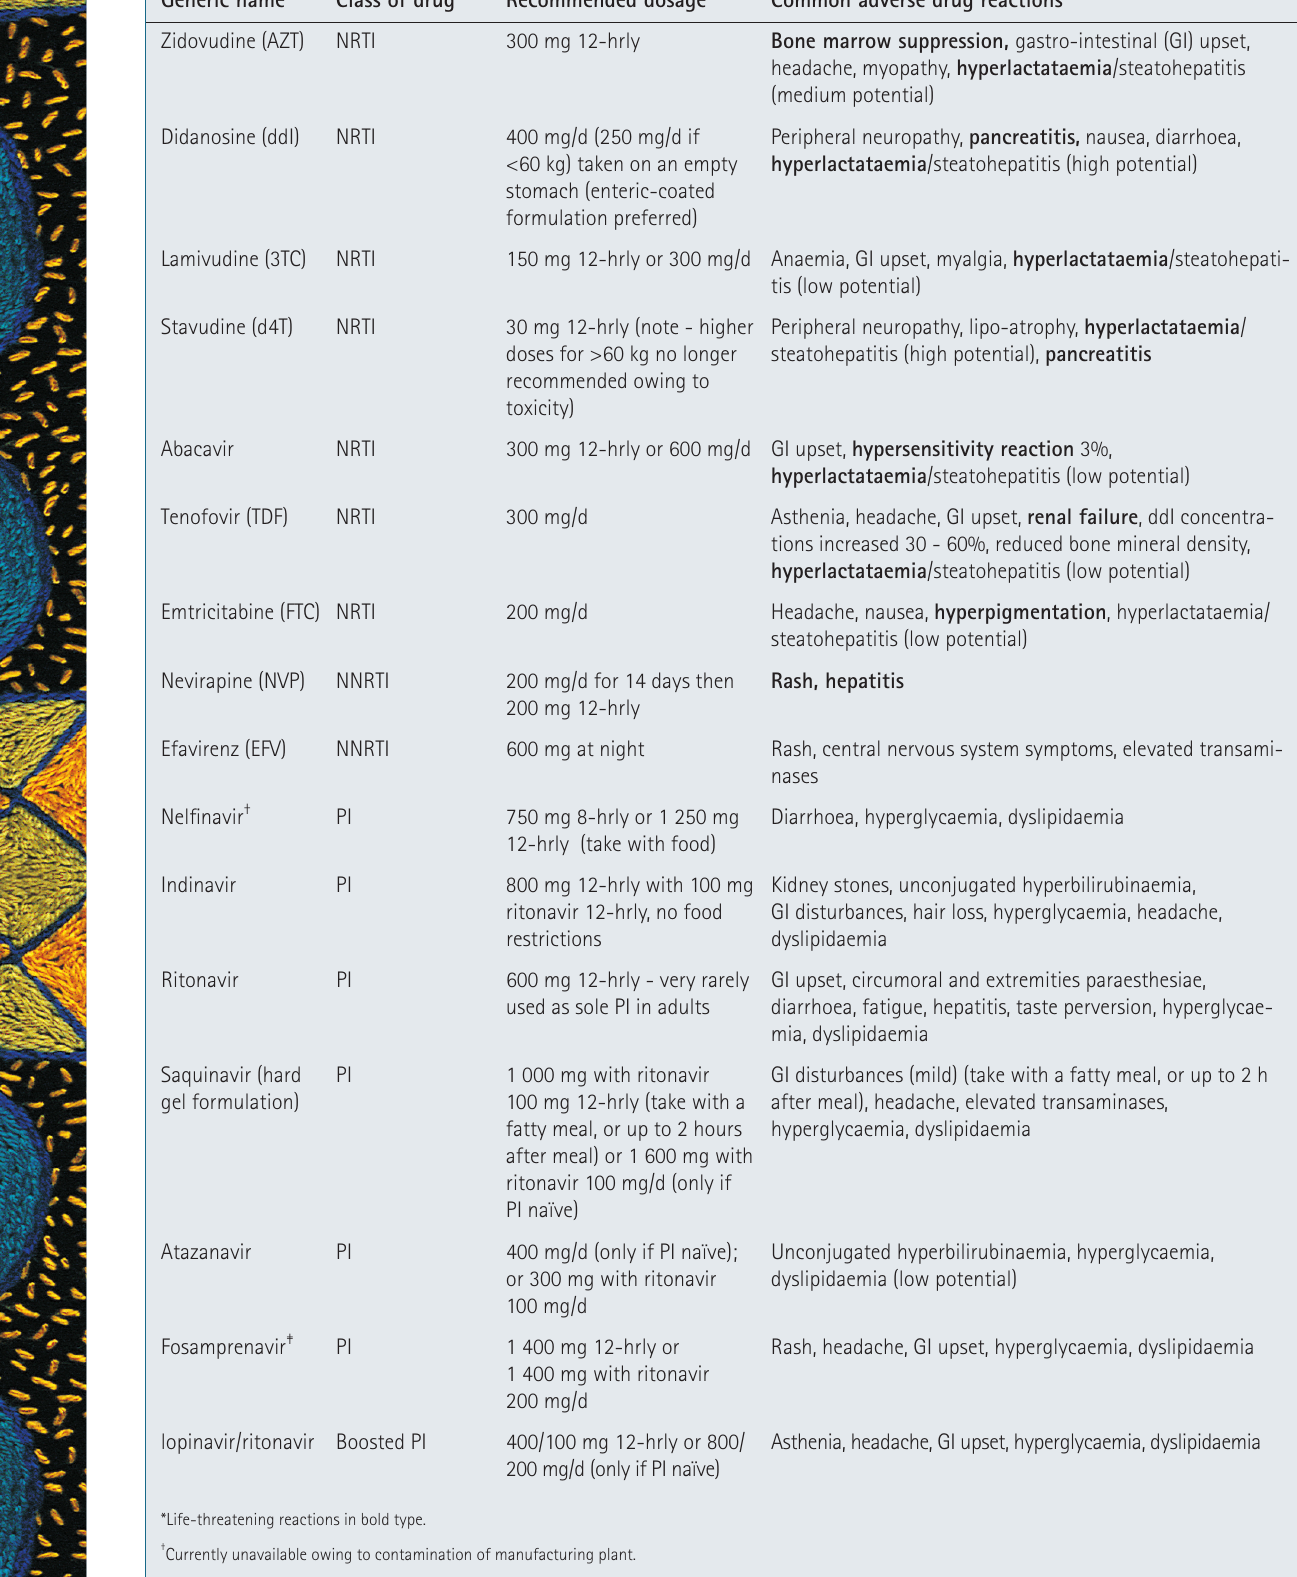
tAble ii. ARV AGeNts cuRReNtly AVAilAble iN southeRN AfRicA ANd coMMoN AdVeRse